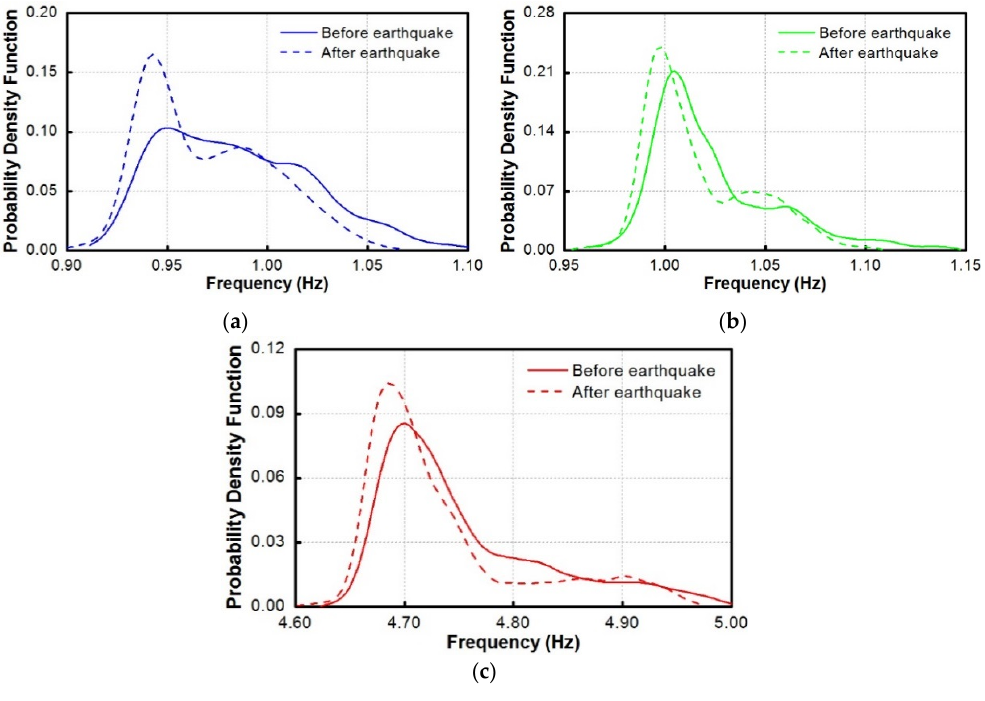
Figure 14. Probability density function of the natural frequency identified from 17/12/2012 to 20/06/2013 (solid line) and after 21/06/2013 (dashed line): ( a ) Mode B 1 ; ( b ) Mode B 2 ; and ( c ) Mode T 1 .